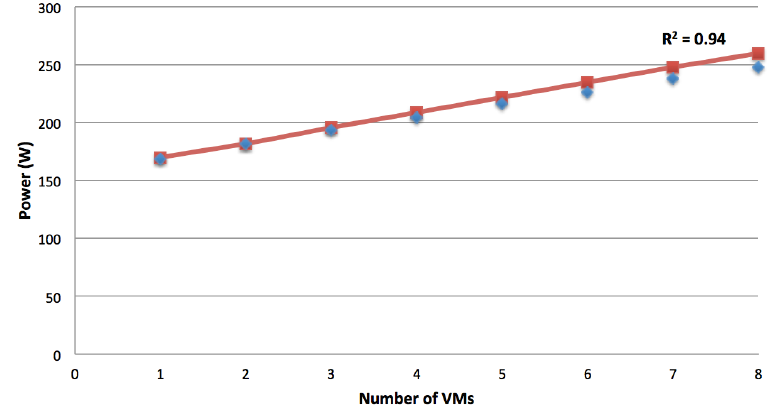
Figure 2. Power consumption related to the number of running